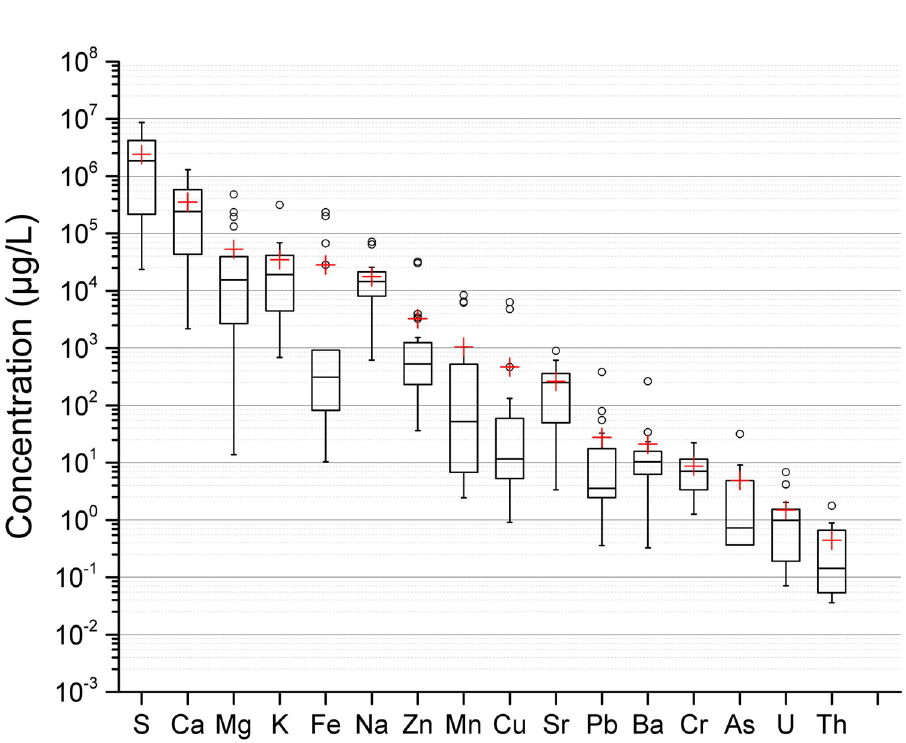
Fig 2. Major and trace metals in μ g/L in surface water from 27 pit lakes. The height of the box shows the interquartile range, which contains 50% of the values, the horizontal line inside the box shows the median value and the red cross denotes the mean value. The whiskers are lines that extend from the box to the highest and lowest values excluding outliers (o). Outliers represent those data with values being 1.5 higher or lower than the height of the box. Detailed data are given in supplementary data